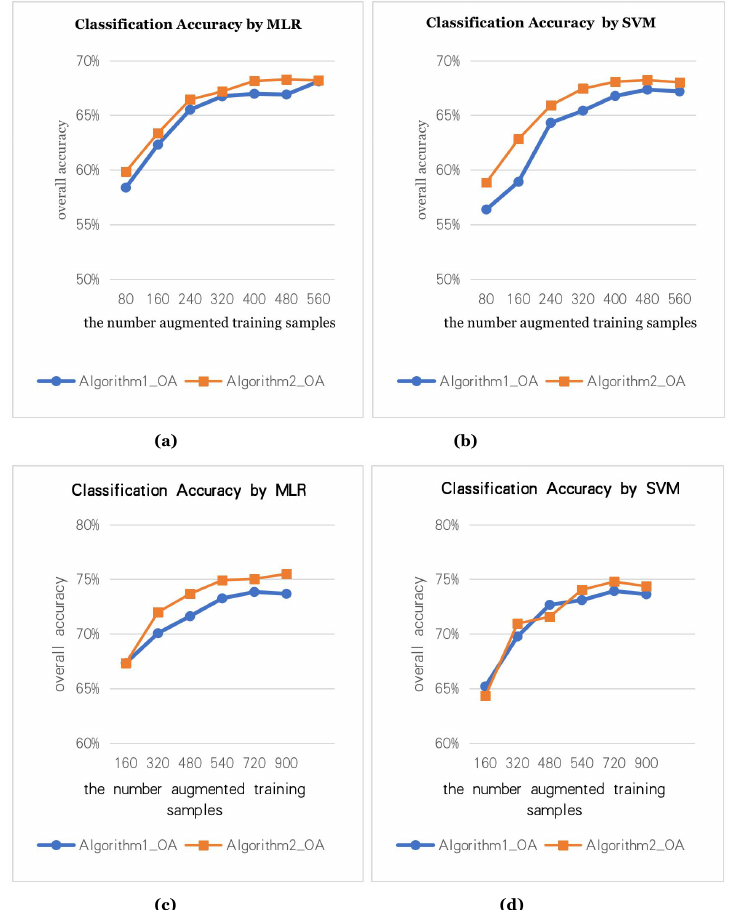
Figure 7. Comparison of classification accuracy of two kinds of augmented training samples on the Indian Pines data: ( a ) the multiple linear regression (MLR) classification accuracy of the augmented training samples with 80 true training samples, ( b ) the support vector machine (SVM) classification accuracy of the augmented training samples with 80 true training samples, ( c ) the MLR classification accuracy of the augmented training samples with 160 true training samples, and ( d ) the SVM classification accuracy of the augmented training samples with 160 true training